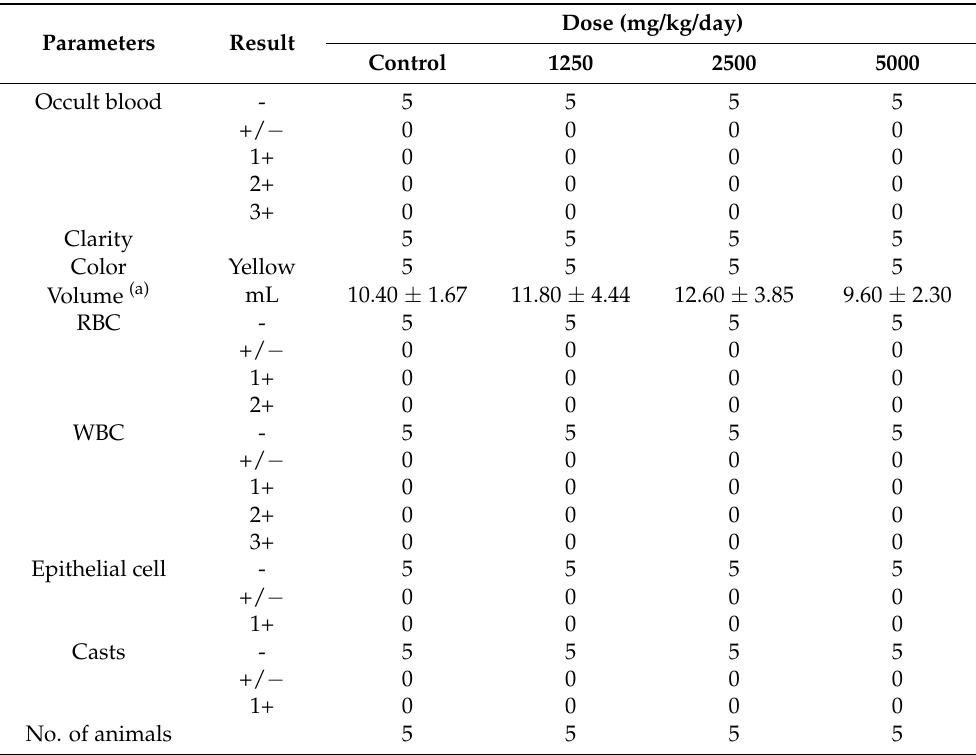
Table 6. Cont. Parameters